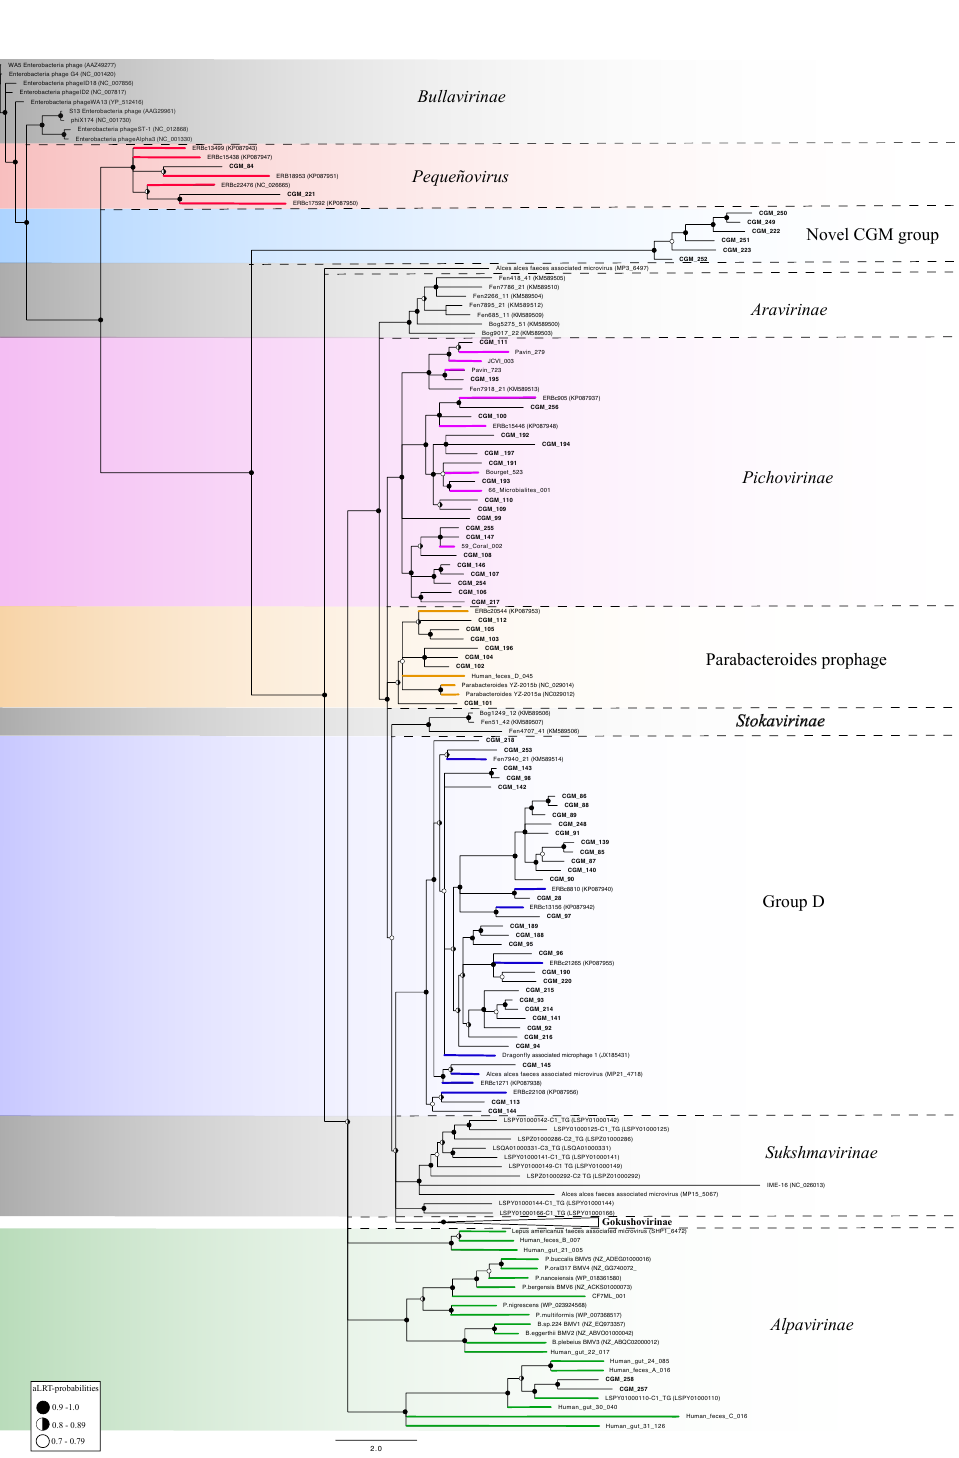
Figure 1. Maximum likelihood phylogenetic tree of predicted major capsid protein (MCP) sequences from the Ciona gut Microviridae (CGM, n = 258) along with representative sequences from previously proposed subfamilies ( n = 96). The tree was created using PhyML with aLRT-probabilities; the scale bar represents the number of amino acid substitutions per site. Branches with probability values less than 0.7 were collapsed. Values greater than 0.7 are indicated at nodes. Suggested subfamily demarcations are delineated with dashed lines and colors based on previously classified sequences. Subfamilies for which CGM sequences were not identified are highlighted in grey color. Note: the Gokushovirinae sub-tree is displayed in Figure 2. Accession numbers for sequences used in this analysis are listed in Supplementary Tables S1 and